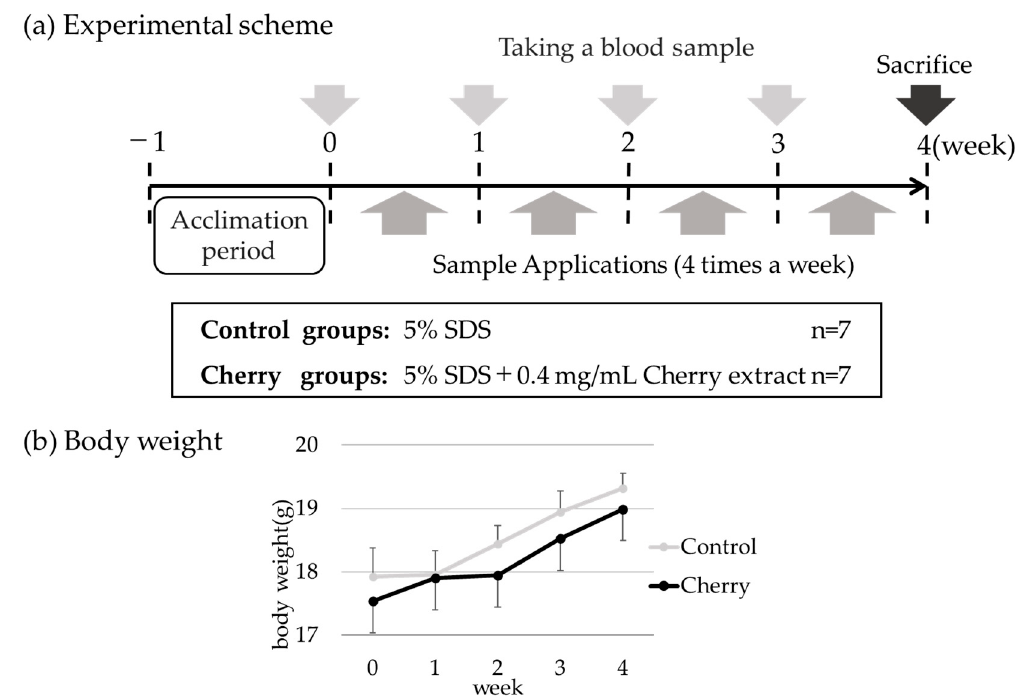
Figure 1. Percutaneous sensitization with cherry extract does not affect mice growth. ( a ) Schema of the percutaneous sensitization protocol. Detailed information is described in “Materials and methods.” ( b ) Body weights of the control group and cherry group. Data are presented as means ± standard deviations (SD); control group ( n = 7), cherry group ( n = 7).